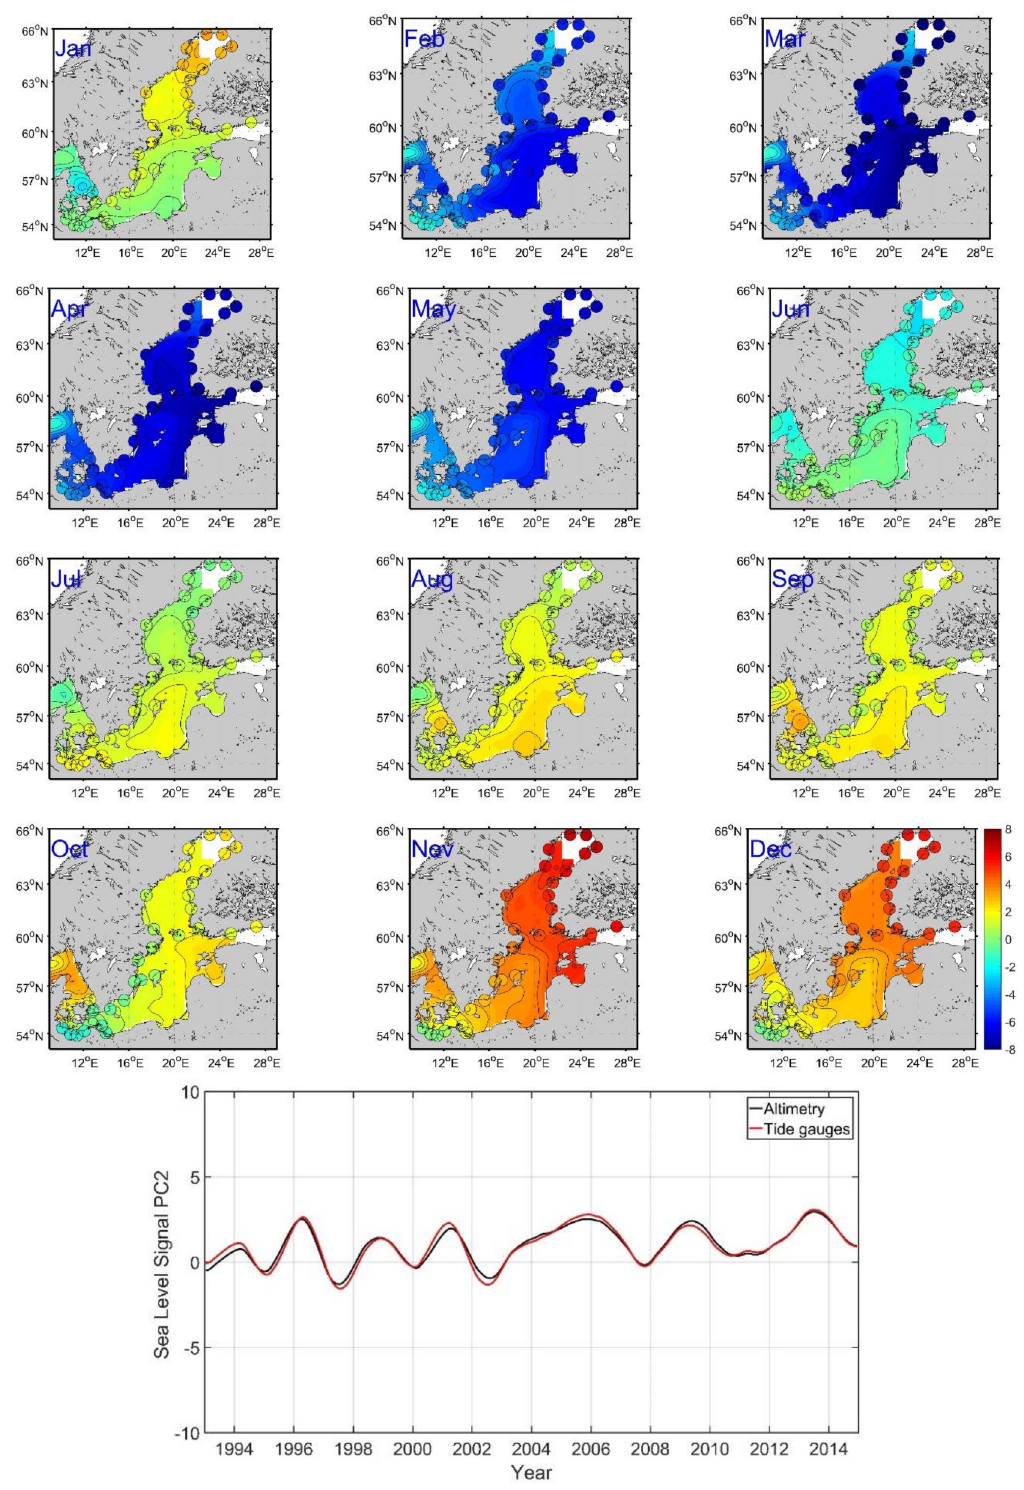
Figure A1. CSEOF second mode captures the spatial patterns (color images) and temporal variations (time series) of long-term sea level cycle: monthly time-dependent LVs (cm, January thru December) computed from satellite altimetry and tide gauge data and the PC time series (PC2, dimensionless) of altimetry data and tide gauge data for 1993–2014. For each dataset, the PCs are normalized with mean PC2 time series and the LVs are times by mean of PC2 time